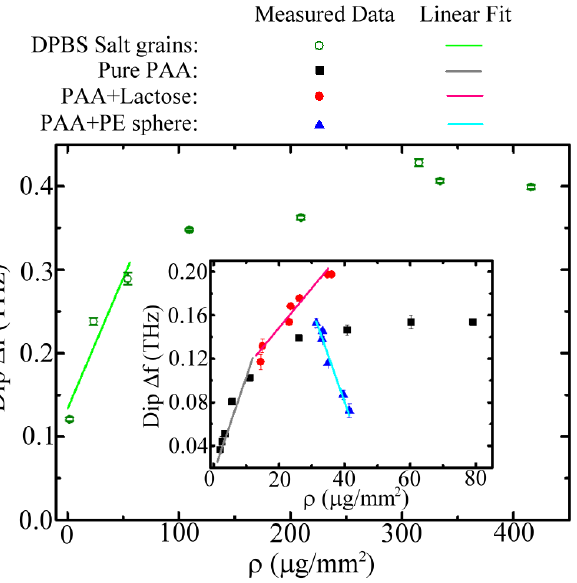
Figure 9. Measured Δ f values of 90 μ m W MCWM at the first spectral dip for depositing different Figure 9. Measured ∆ f values of 90 µ m W MCWM at the first spectral dip for depositing different kinds and amounts of analytes. kinds and amounts of